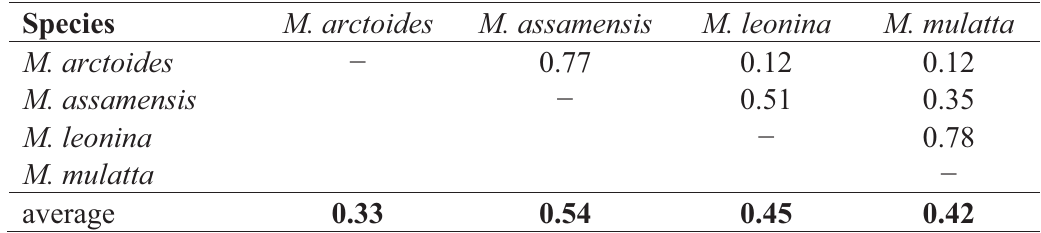
Table 5. Range overlap index between the four macaque species using a threshold of presence of 0.171; range overlap between species x and y = (N is the number of grid cells where both species x and y are predicted and N number of grid cells where respectively species x and y are